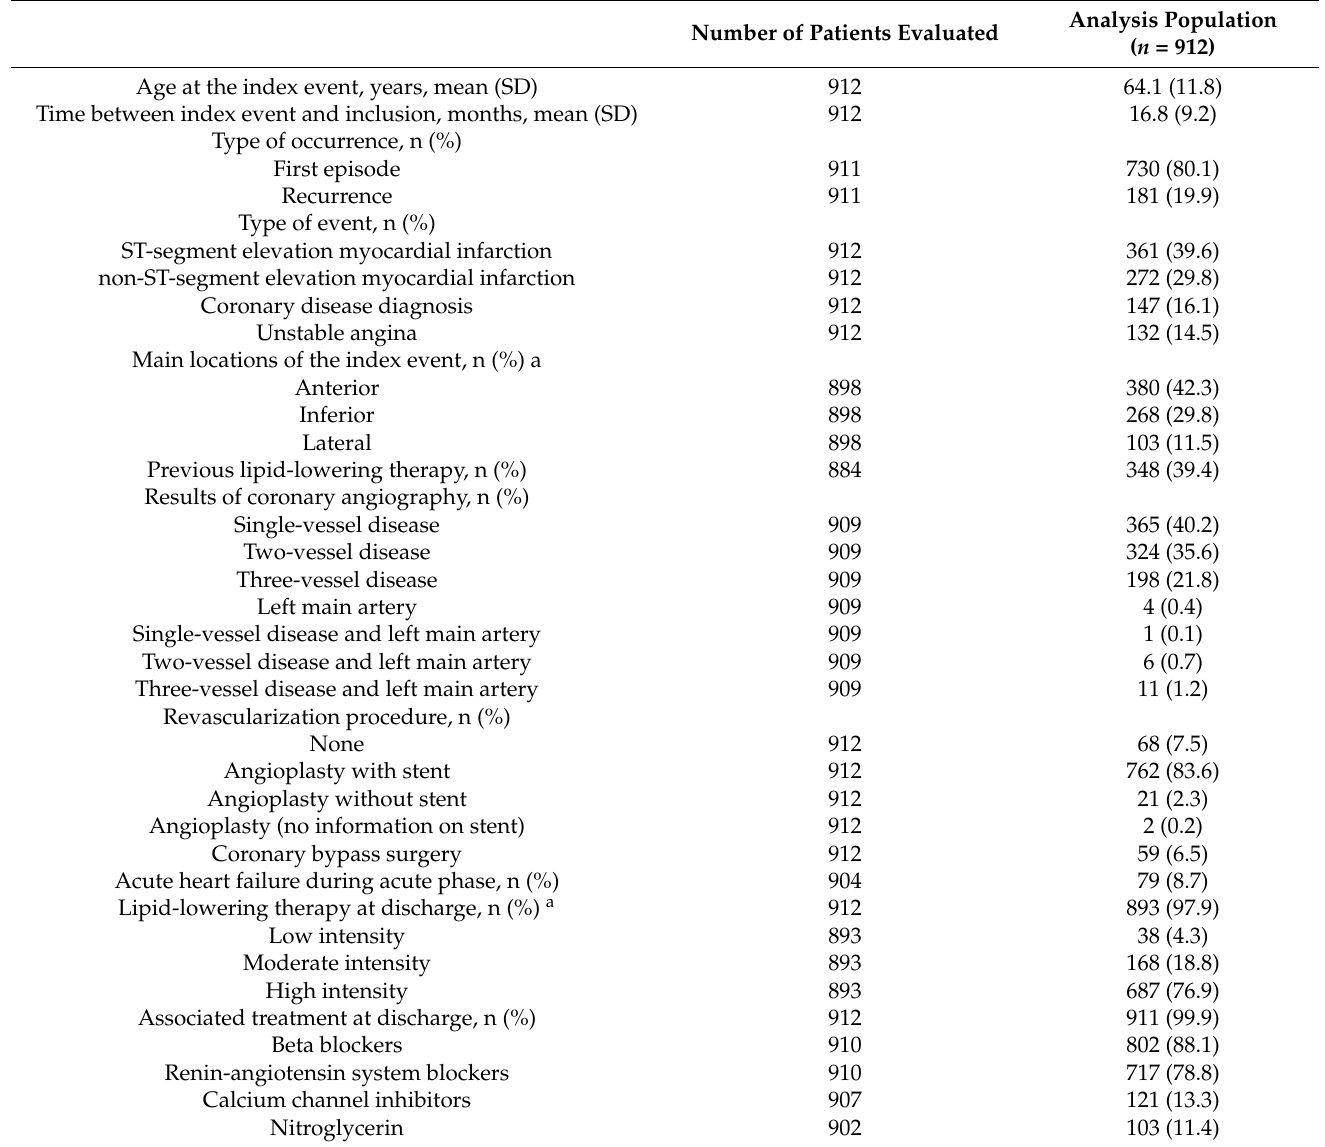
Table 2. Characteristics of the index cardiac event of the very high-risk CAD study patients.